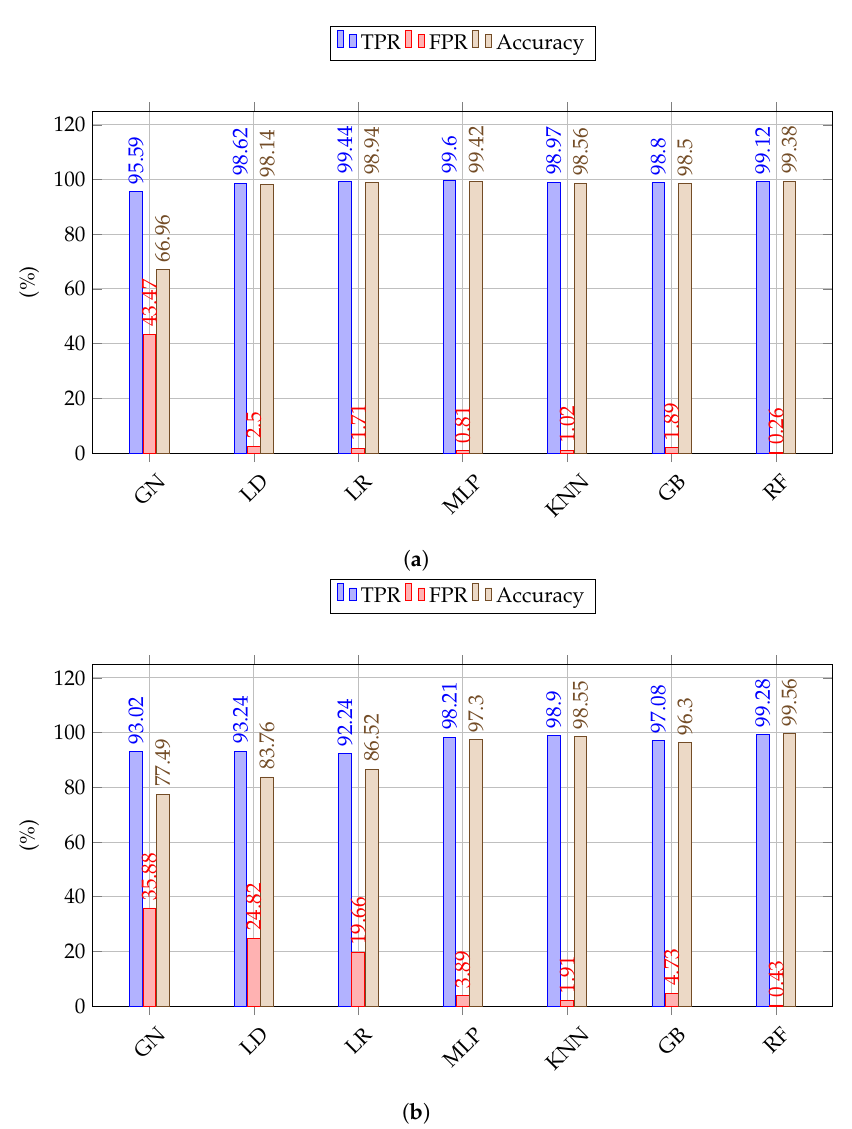
Figure 6. Results of different classifiers for malware detection problem. ( a ) Full Features; ( b ) Selected